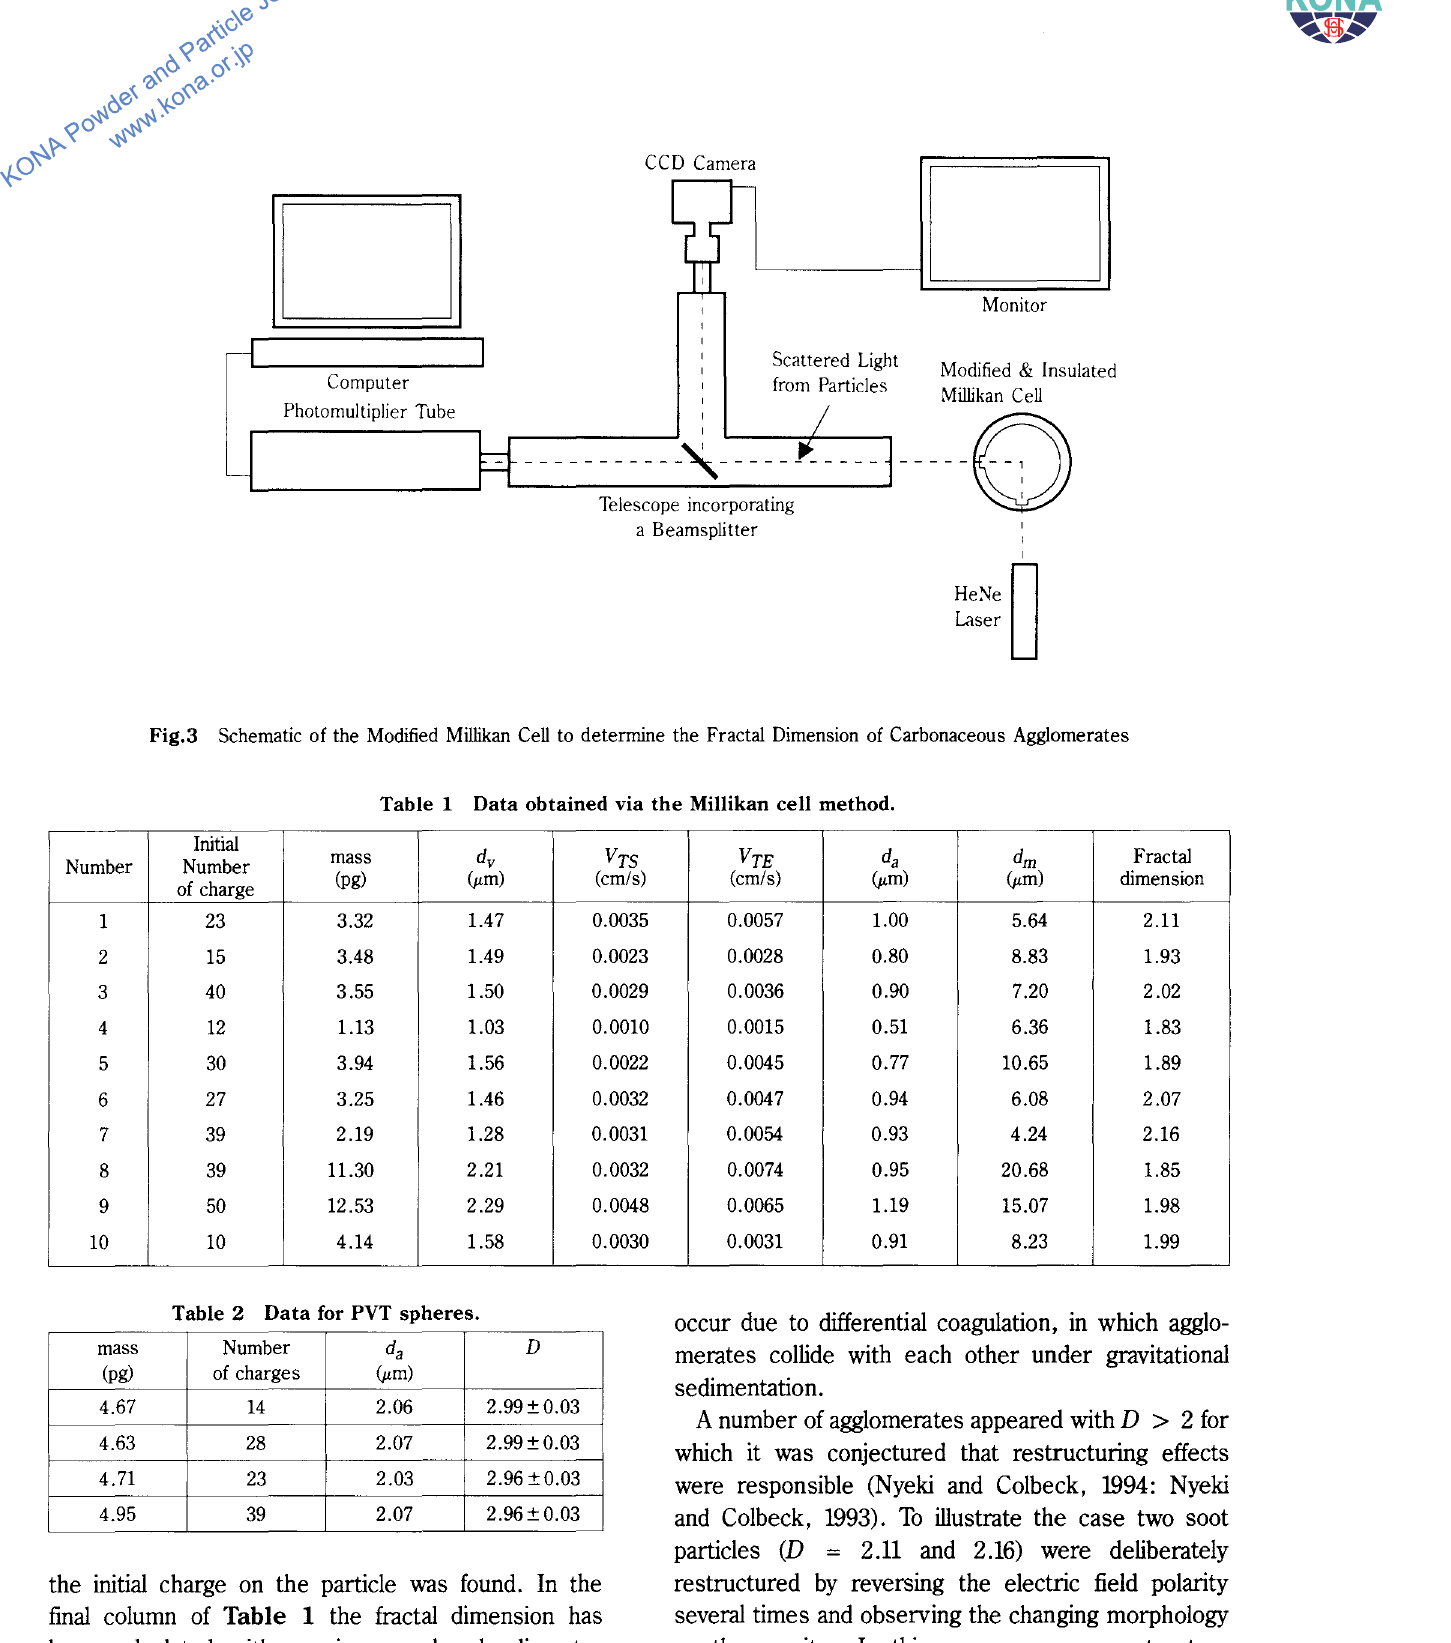
Fig.3 Schematic of the Modified Millikan Cell to determine the Fractal Dimension of Carbonaceous Agglomerates